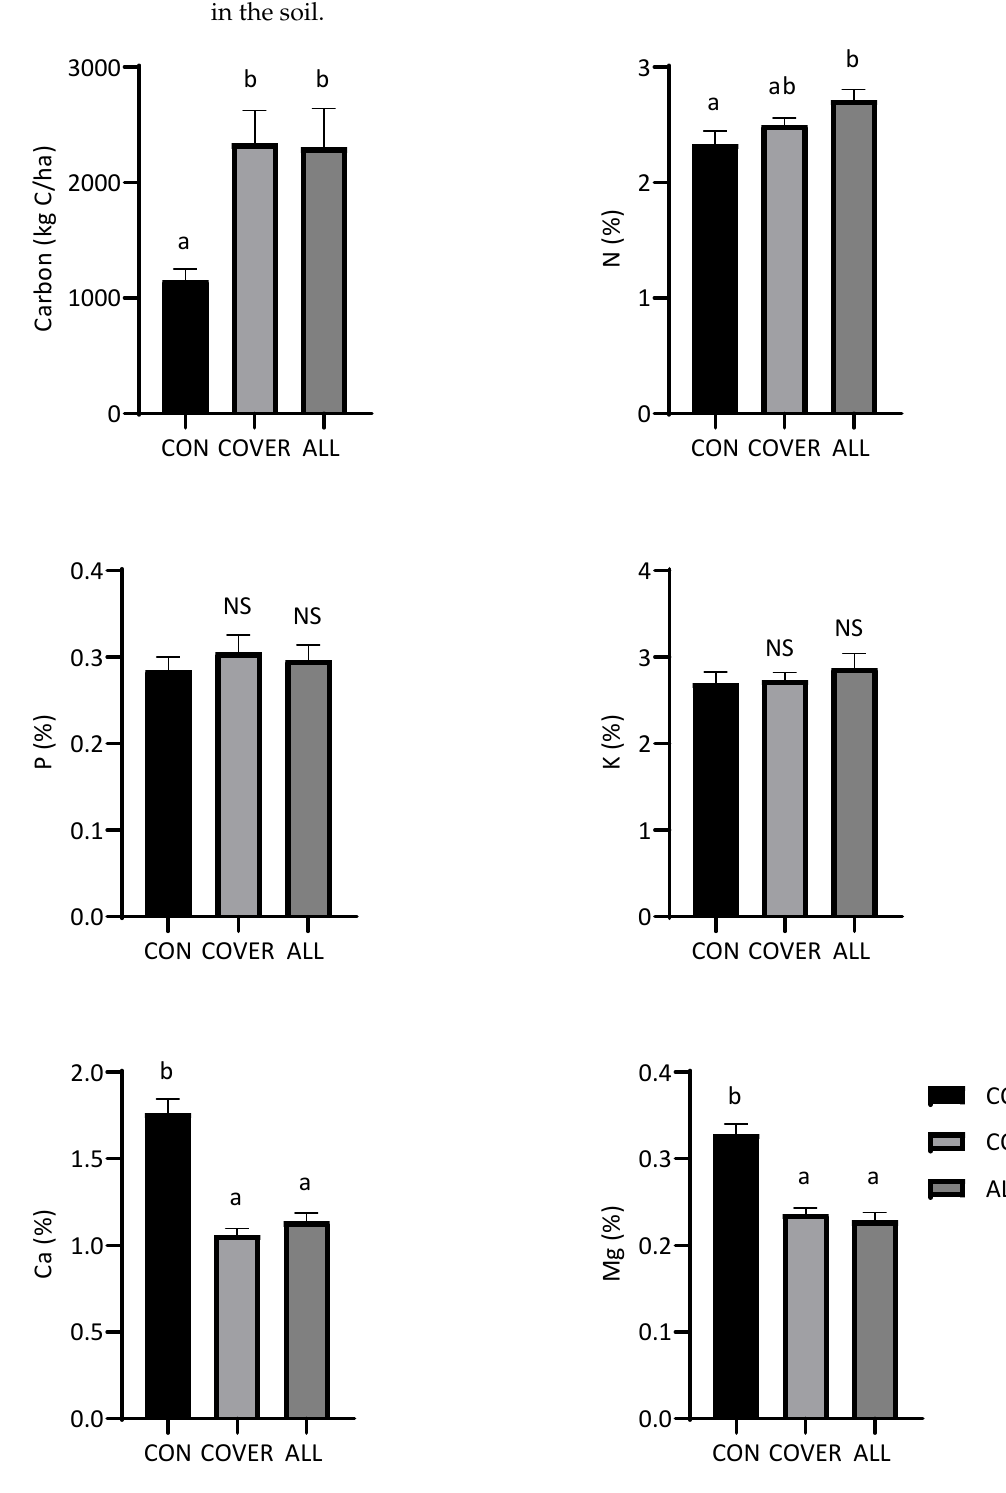
Figure 4. Carbon content (kg C/ha) and nutrient concentrations (% dry weight) of seeded cover crops in the COVER and ALL treatments and spontaneous plants in the CON treatment. Mean values ± SE per each treatment is presented. Different letters indicate significance at p < 0.05 (LSD test). The C content was significantly higher in COVER (2337.91 kg ha −1 year −1 ) and ALL (2303.42 kg ha −1 year −1 ) compared to CON (1155.90 kg ha −1 year −1 ) (F: 6.603, p < 0.05). The C content of cover crops from our study has a pattern similar to that obtained by Rodríguez-Lizana et al. [33]. Moreover, the presence of cover crops in olive groves leads to an increase in soil organic carbon (SOC), which is supported by the study results of Repullo-Ruibérriz de Torres et al. [34]. However, the Ca (F: 45.215, p < 0.05) and Mg content (F:33.792, p < 0.05) was signifi- cantly higher in CON (1.77% Ca, 1.33% Mg) compared to ALL (1.14% Ca, 0.23% Mg) and